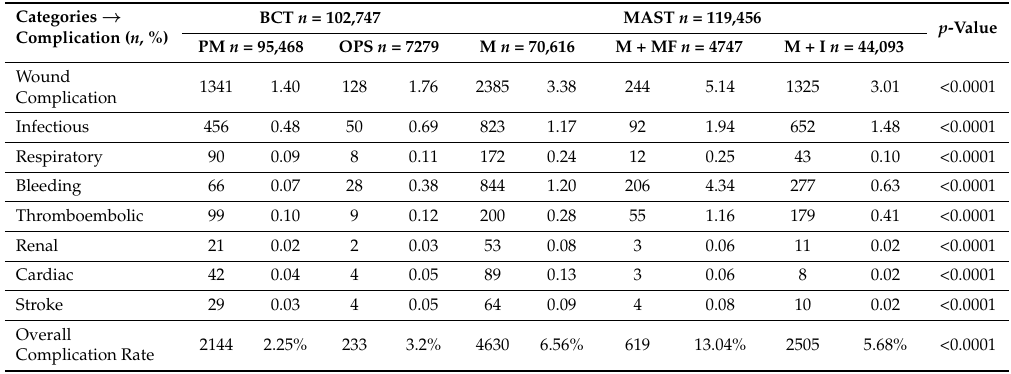
Table 4. Complication rate in Surgical interventions.